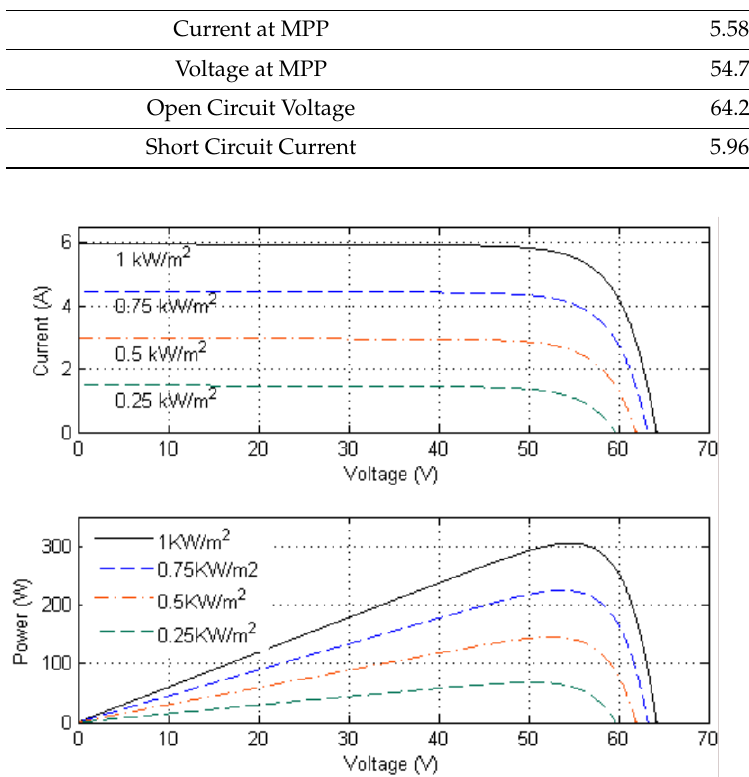
Figure 5. Photovoltaic module characteristics at different irradiance